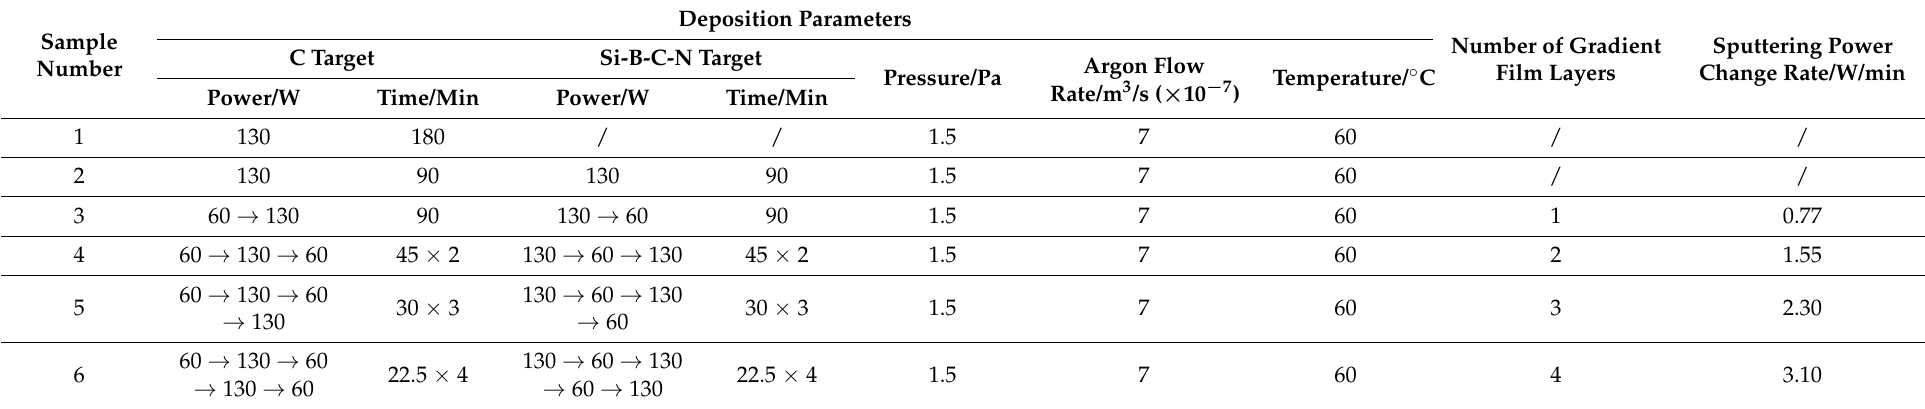
Table 1. Deposition parameters of the Si-B-C-N/DLC gradient